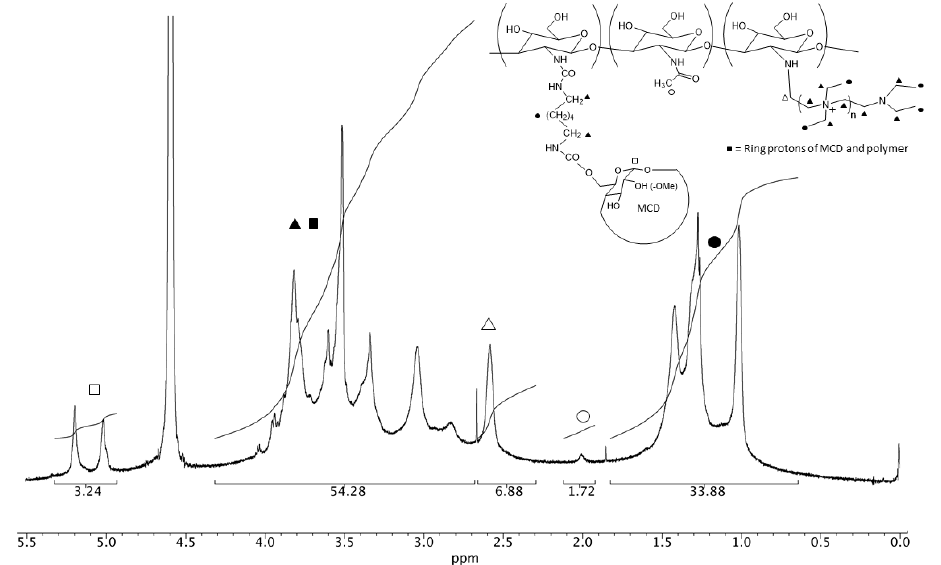
Figure 2. 1 H NMR spectrum (600 MHz, D 2 O, 37 °C) of N + -rCh-MCD (3.7 mg/mL). Black and white dots, squares and triangles refer to the corresponding protons marked on the structure.